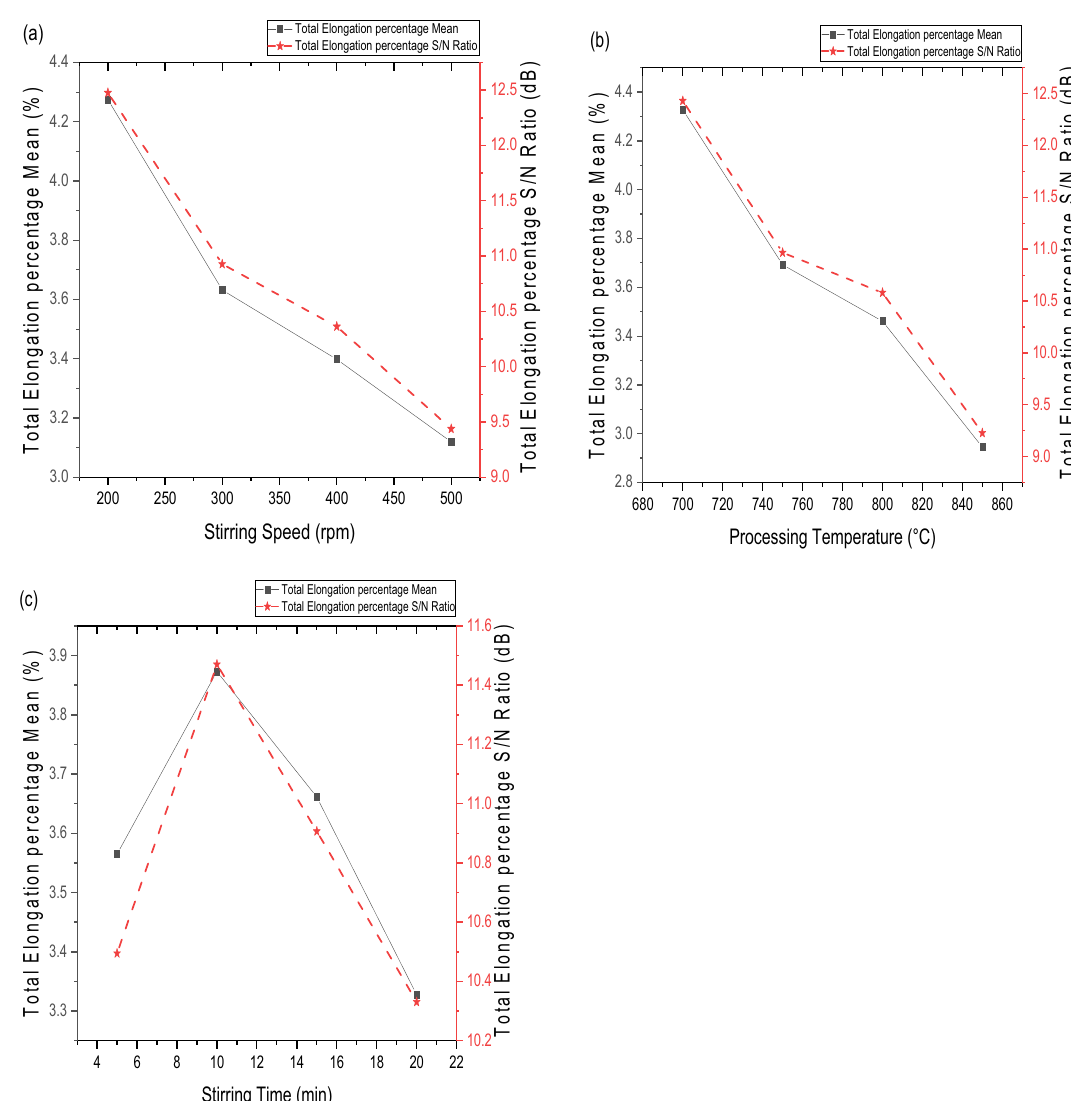
Figure 5. Variation of percentage elongation with stirring process parameter; ( a ) stirring speed vs percentage elongation, ( b ) processing temperature vs percentage elongation ( c ) stirring time vs percentage